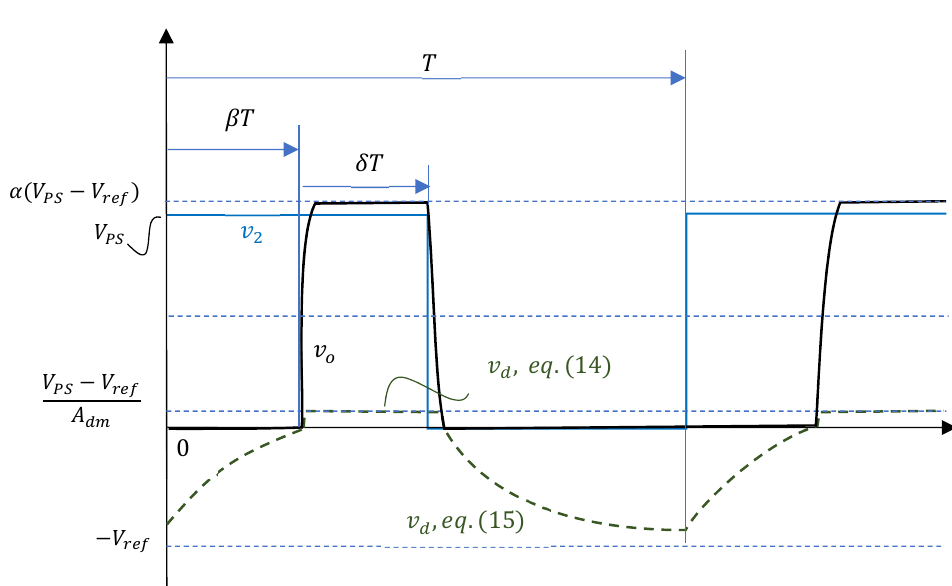
Figure 10. Response of a cCCDA with large resistance.